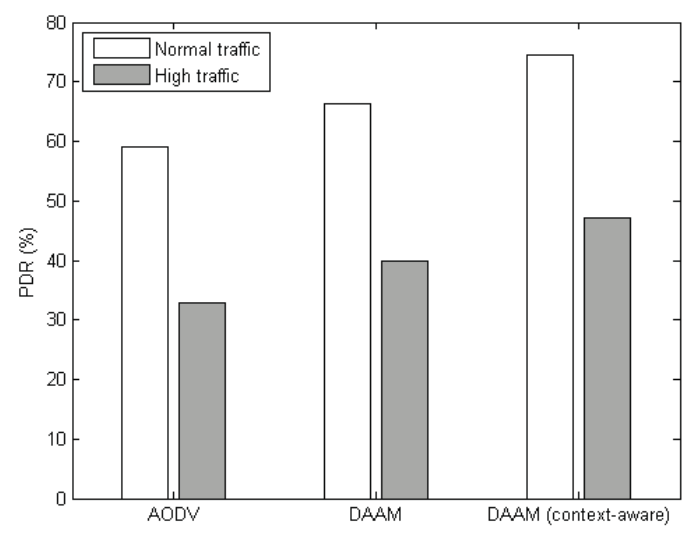
Figure 11. PDR of NET